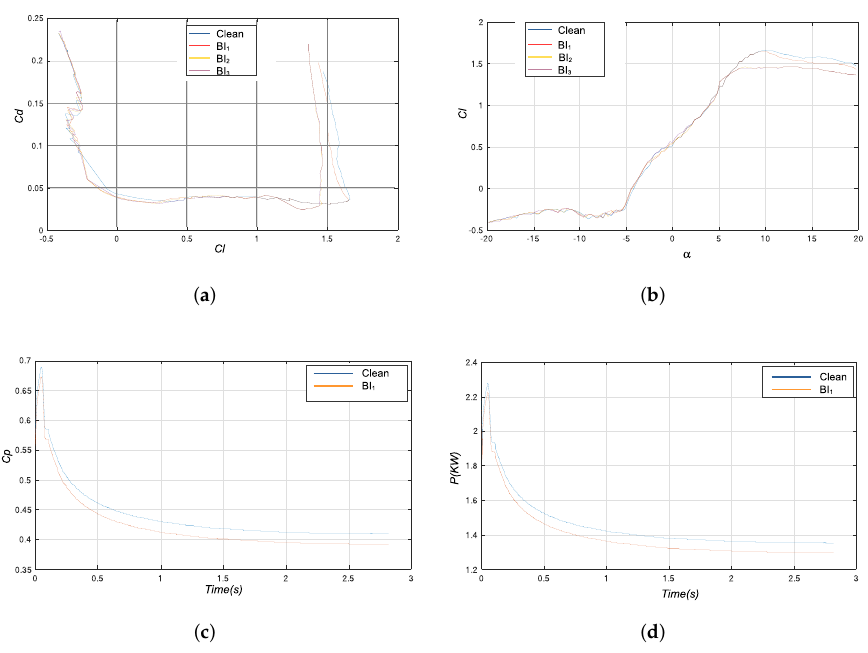
Figure 3. ( a ) Relationship between the drag coefficient ( C D ) and the lift coefficient ( C L ). ( b ) Lift coefficient C L Vs angle of attack α . ( c ) Power coefficient C p for BI 1 and the clean wind turbine blade. ( d ) Power output P G for BI 1 and the clean blade.